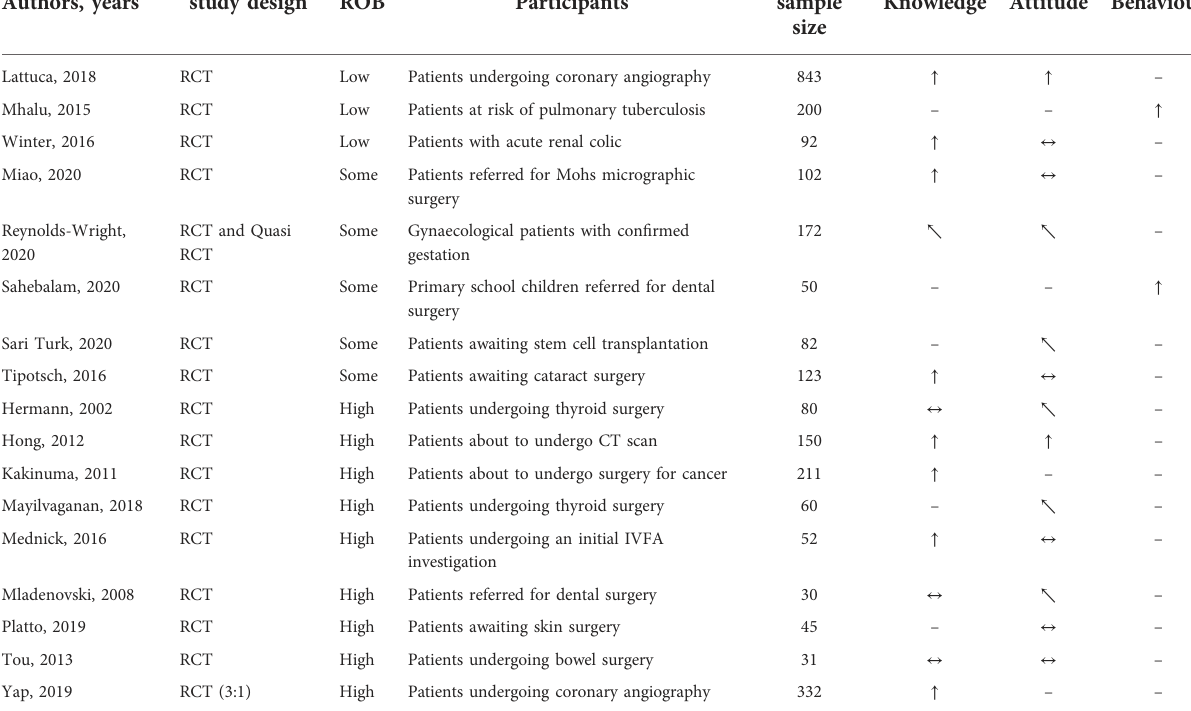
TABLE 1 Category 1 fi ndings (explaining medical or surgical procedures).